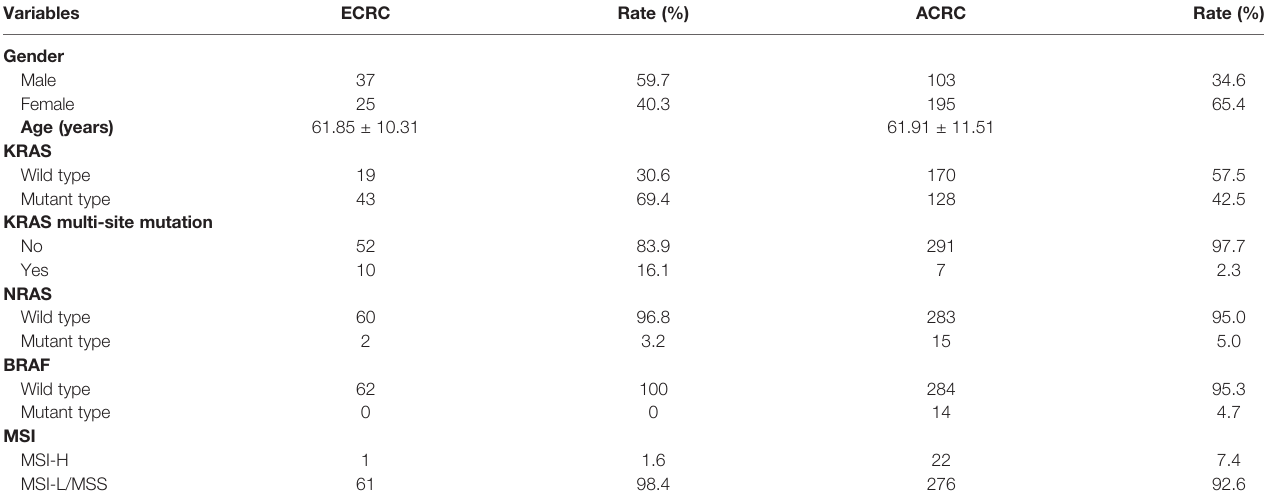
TABLE 3 | Differences in KRAS/NRAS/BRAF mutation and MSI between ECRC and